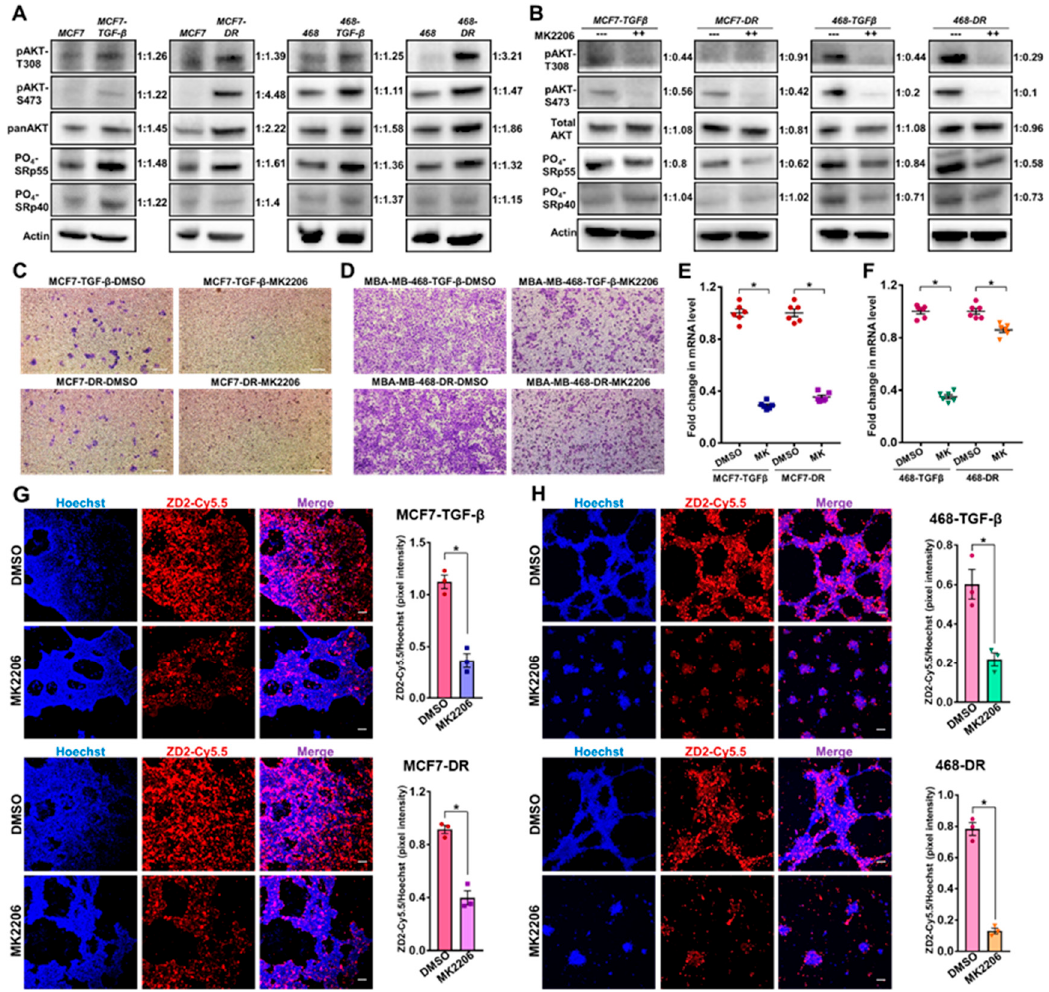
Figure 4. Therapeutic ablation of phospho-AKT in invasive TGF- β -treated and drug-resistant breast cancer cells reduces their invasion and EDB-FN overexpression. ( A ) TGF- β treatment and drug resistance upregulate phospho-AKT signaling and phosphorylation of SRp55 in MCF7 and MDA-MB-468 cells. ( B ) Treatment of cells with AKT inhibitor MK2206-HCl (2 µM for MCF7 and 4 µM for MDA-MB-468 cells) for 2 days results in inhibition of phospho-AKT signaling in the invasive breast cancer cell lines. The SRp55 upregulation is diminished with MK2206-HCl-mediated depletion of phospho-AKT signaling, suggesting a potential role of SRp55 in the inclusion of EDB-FN exon. The western blot band intensities were normalized to those of actin bands in FIJI, and the protein level changes are expressed as ratio of treated over non-treated, next to the respective lanes. Inhibition of phospho-AKT signaling by MK2206-HCl demonstrates reduced invasive potential of the invasive ( C ) MCF7 and ( D ) MDA-MB-468 cell derivatives along with decreased expression of EDB-FN at ( E ) and ( F ) mRNA levels and ( G ) and ( H ) in 3D culture, respectively. Dots denote 2 technical replicates from 3 independent experiments, with lines at mean ± sem. ( G–H ) ZD2 peptide binding to EDB-FN was quantified in FIJI as the ratio of the pixel intensities of ZD2-Cy5.5 to that of Hoechst. Bars denote mean ± sem and dots denote independent replicates. * p < 0.05 using Mann–Whitney U test. Scale bars = 100 µ